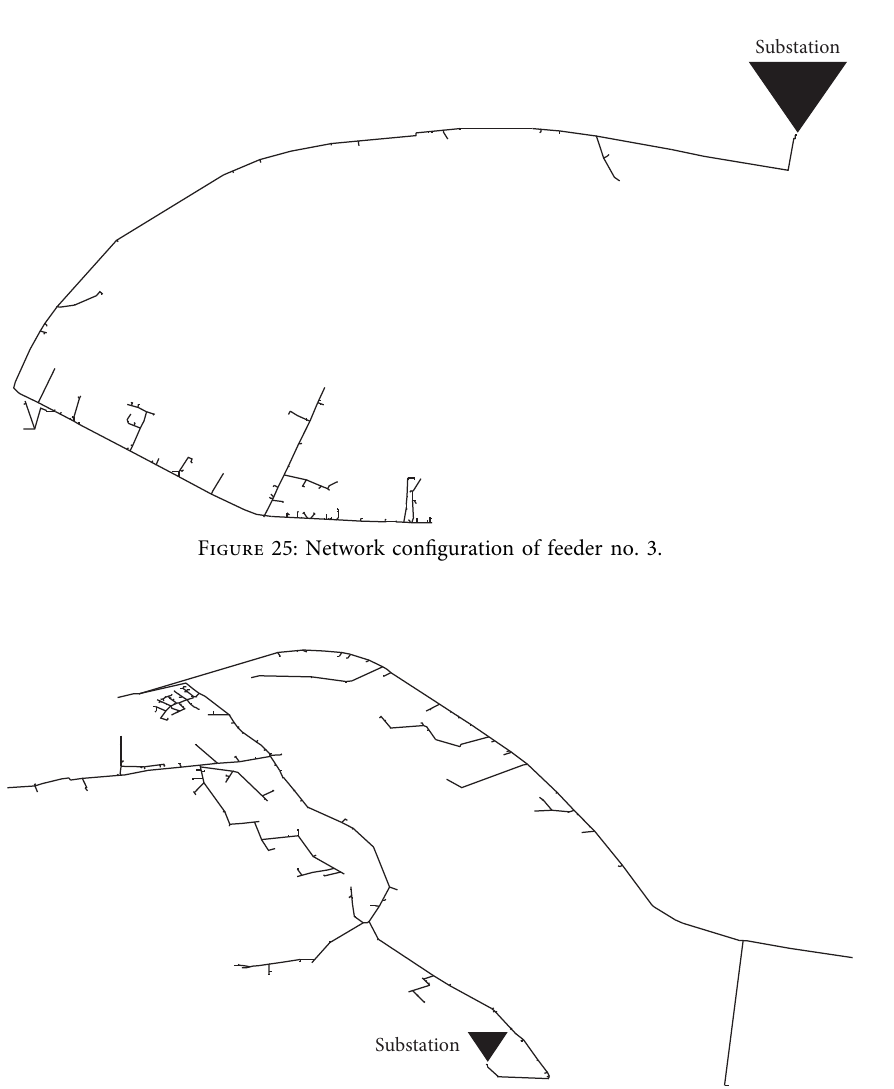
Figure 26: Network confguration of feeder no.